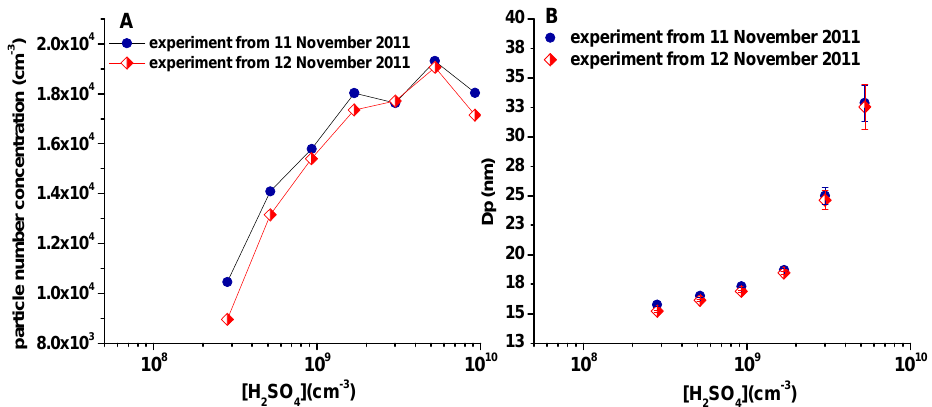
Figure 2. The variation of the total particle concentrations determined from a DMPS from measurements performed at T = 283K, with an RH of ∼ 1% and a residence time of 60s, taken 1day apart. Fig. 2b: the median particle diameters determined from measurements performed at T = 283K, with an RH of ∼ 1% and a residence time of 60s, taken 1day apart. The standard deviations of the median particle diameters are depicted as error bars.